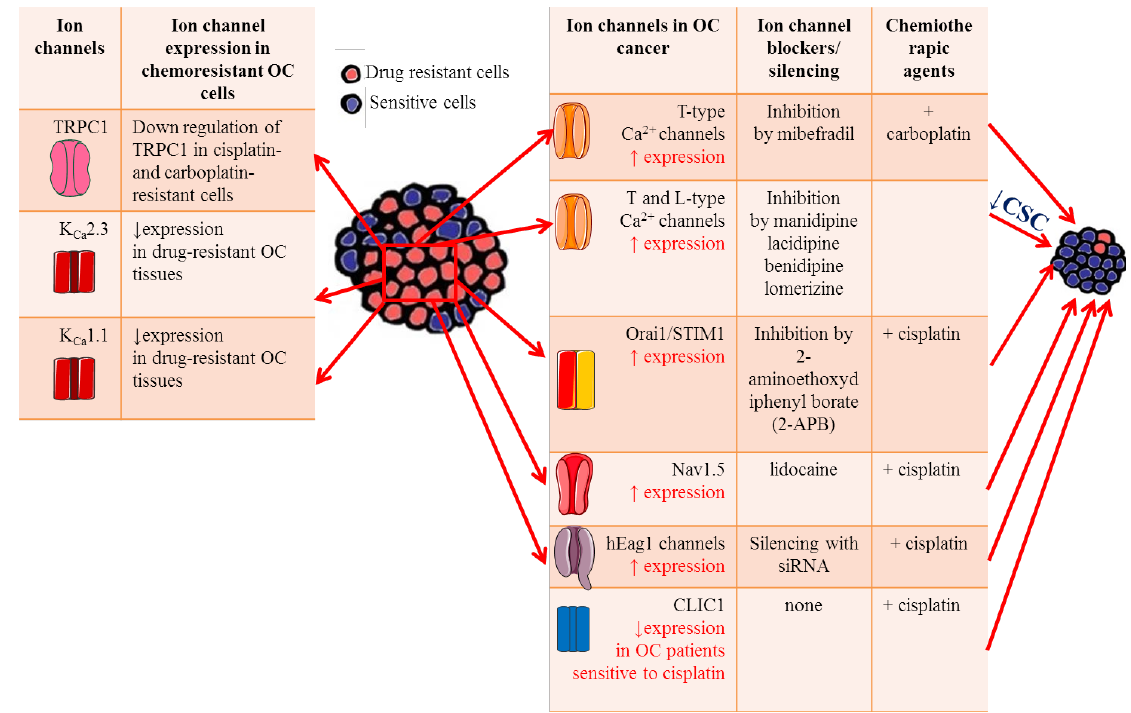
Figure 2. Ion channels roles in OC drug resistance. Table on the left summarizes the main ion channels likely involved in OC drug resistance, focusing on their expression level on OC cells and tissues. Table on the right lists the effects of ion channel blockers on chemosensitivity to platinum-based agents.